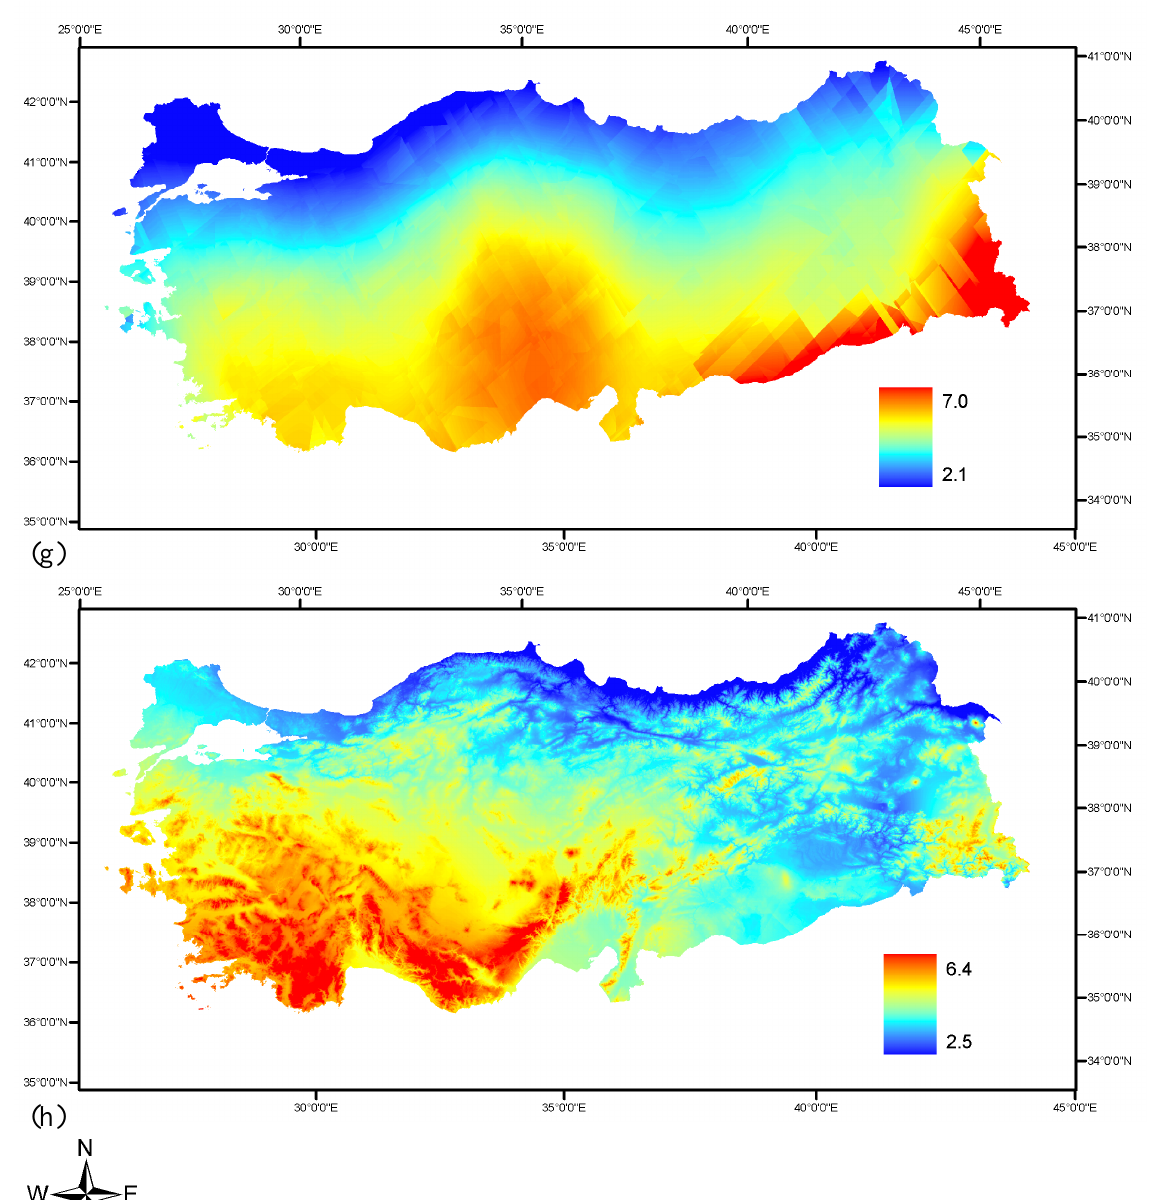
Figure 1. Comparison of spatial interpolation methods to map monthly mean daily incident photosynthetically active radiation (PAR, MJ m -2 day -1 ) over Turkey: digital maps with a grid resolution of 500 x 500 m of PAR in (a) February, (c) May, (e) August and (g) November based on universal kriging (see Table 4 for semi-variogram models and spatial one-leave-out cross-validation statistics) and in (b) February, (d) May, (f) August and (h) November based on multiple linear regression (MLR) models (see Table 3 for MLR models and validation